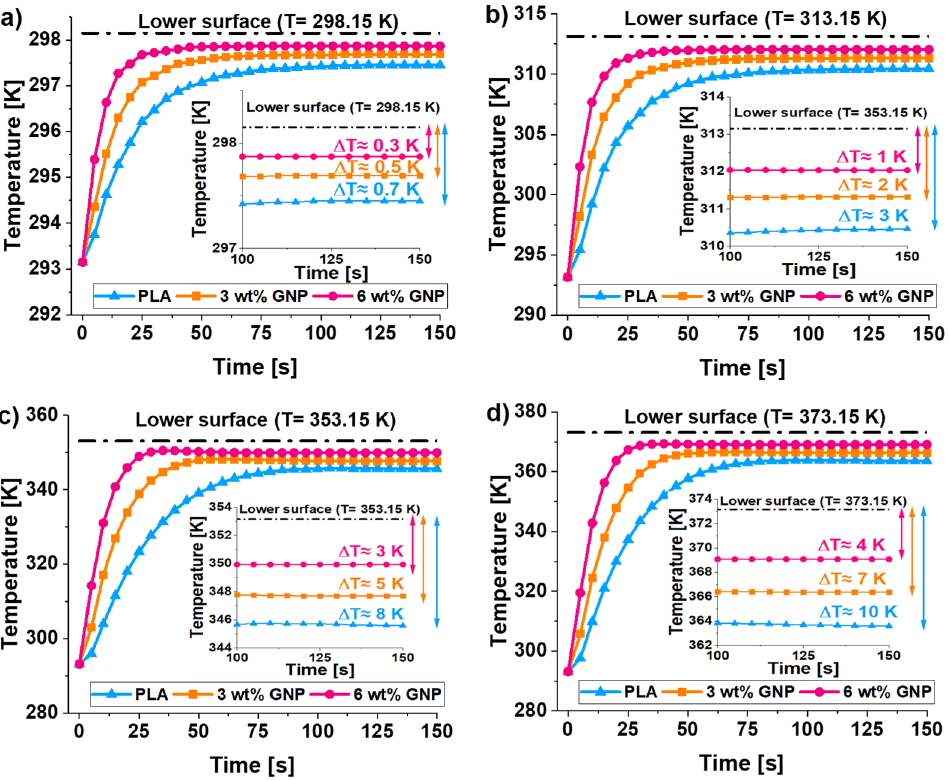
Figure 8. Comparison of the temperature profiles (average values) recorded on the upper surfaces vs. time for heat sink based on pure PLA, PLA reinforced with 3 and 6 wt% of GNPs different temperatures, i.e., 298.15, 313.15, 353.15, and 373.15 K, are considered in ( a – d ), respectively.